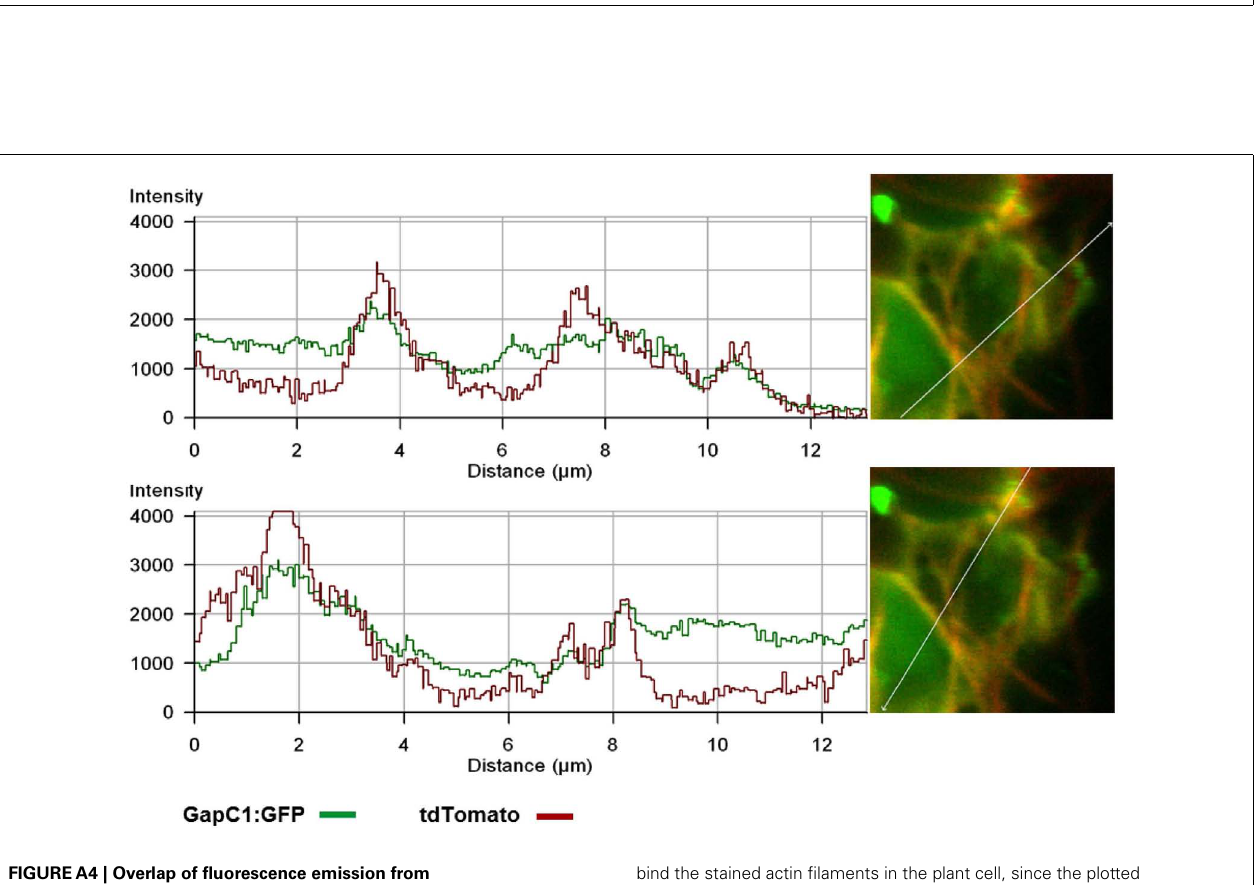
bind the stained actin filaments in the plant cell, since the plotted fluorescent signals partially cover the same regions along a distance of approximately 12 µ m.The diagram was performed with the Zeiss LSM 5